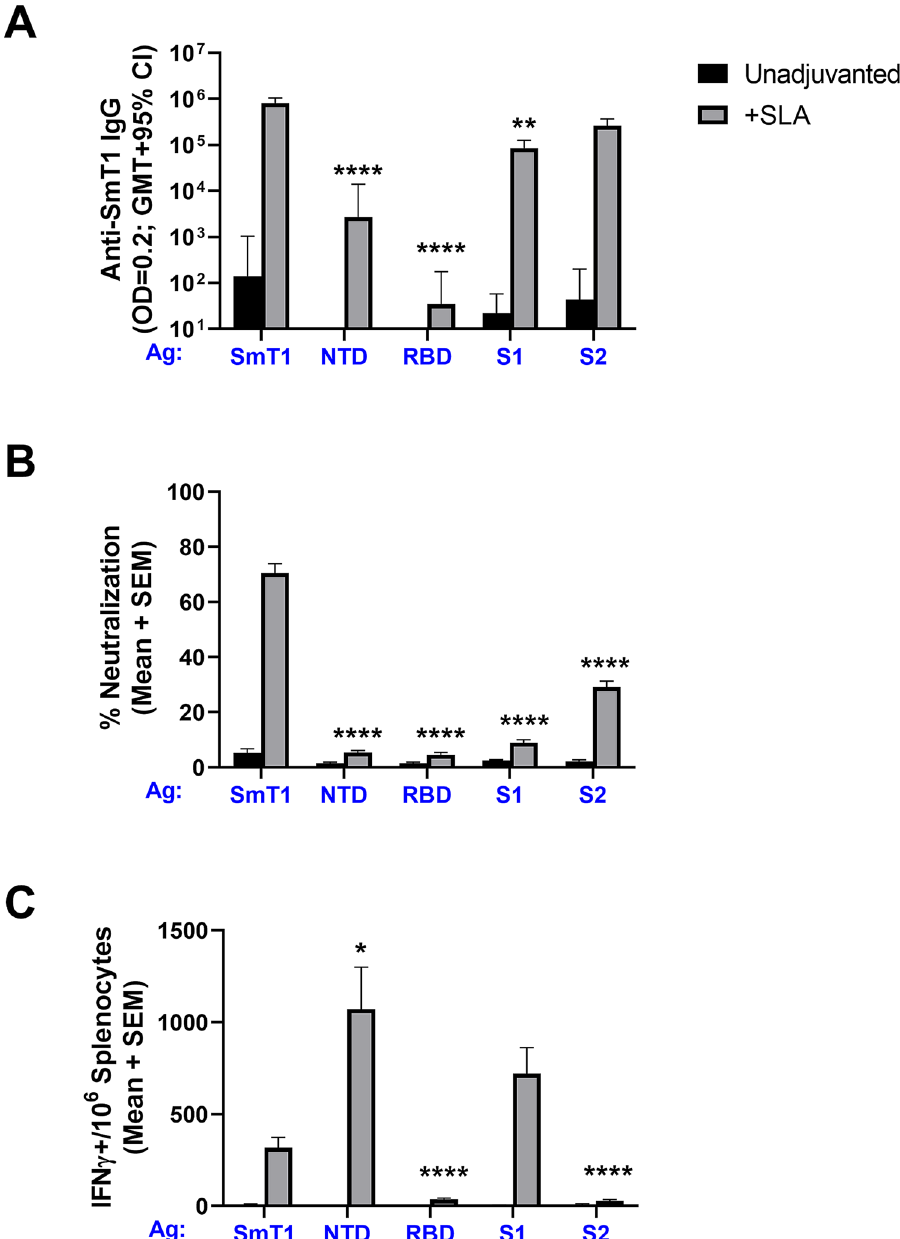
Figure 2. Comparison of immunogenicity of various spike-derived antigen formats delivered with SLA adjuvant. C57BL/6 mice (n = 10/group) were immunized i.m. with 2 µg of SmT1, spike NTD, RBD, S1 or S2 alone or with SLA archaeosomes on Days 0 and 21. Serum was collected on Days 28 and analyzed by ELISA to determine the antibody titers ( A ). Grouped data is presented as geometric mean + 95% confidence interval. Serum from Day 28 was also analyzed at a final serum dilution of 1:75 by surrogate neutralization assay ( B ). Grouped data is presented as mean + standard error of mean. Splenocytes were harvested on Day 28 and analyzed by IFN-γ ELISpot when stimulated by spike peptide pools ( C ). Values obtained with media alone were subtracted from those measured in the presence of the peptides. Grouped data is presented as mean + standard error of mean (SEM). Statistical significance of differences for the adjuvanted subdomain groups vs. SmT1 + SLA group is shown: *p < 0.05, **p < 0.01 and ****p < 0.0001 by one-way ANOVA followed by Tukey’s multiple comparisons